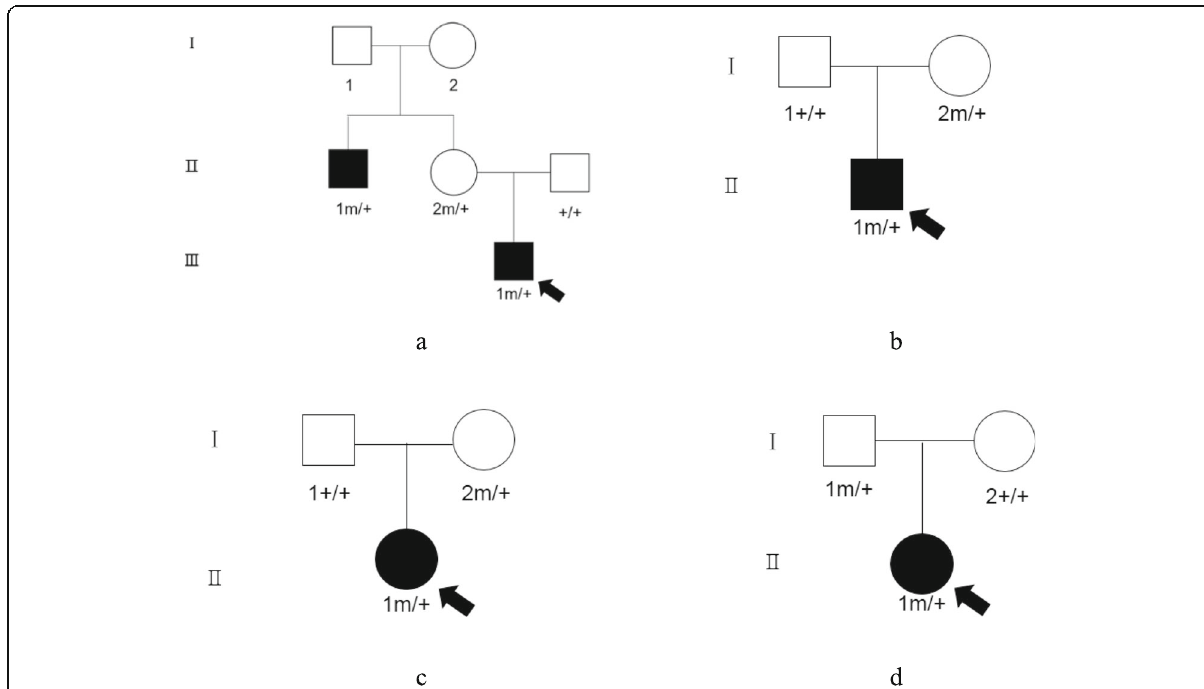
Fig. 2 a - d Genealogic tree of patient 3, 5, 6 and 7. The solid squares indicate patients with epilepsy while the hollow ones indicate healthy people. The letter “ m ” indicates the carrier of variants while “ + ” indicates wild